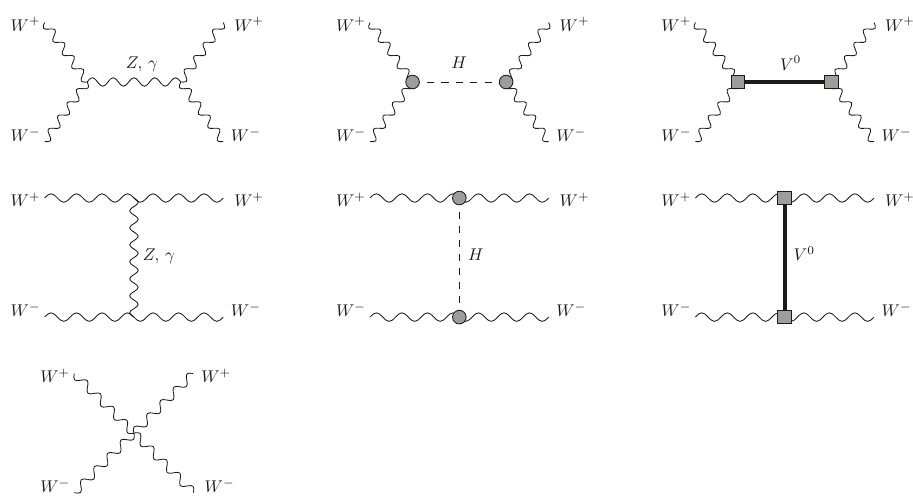
Figure 1 . Feynman diagrams contributing to the process W + W within our e(cid:11)ective Lagrangian formalism. Gray circles (middle diagrams) represent the V vertex given in eq. (2.9) in terms of the EChL parameter a and gray squares (right diagrams) represent the V vertex in eq. (2.8) in terms of the g V Proca W + W (cid:0) V 0